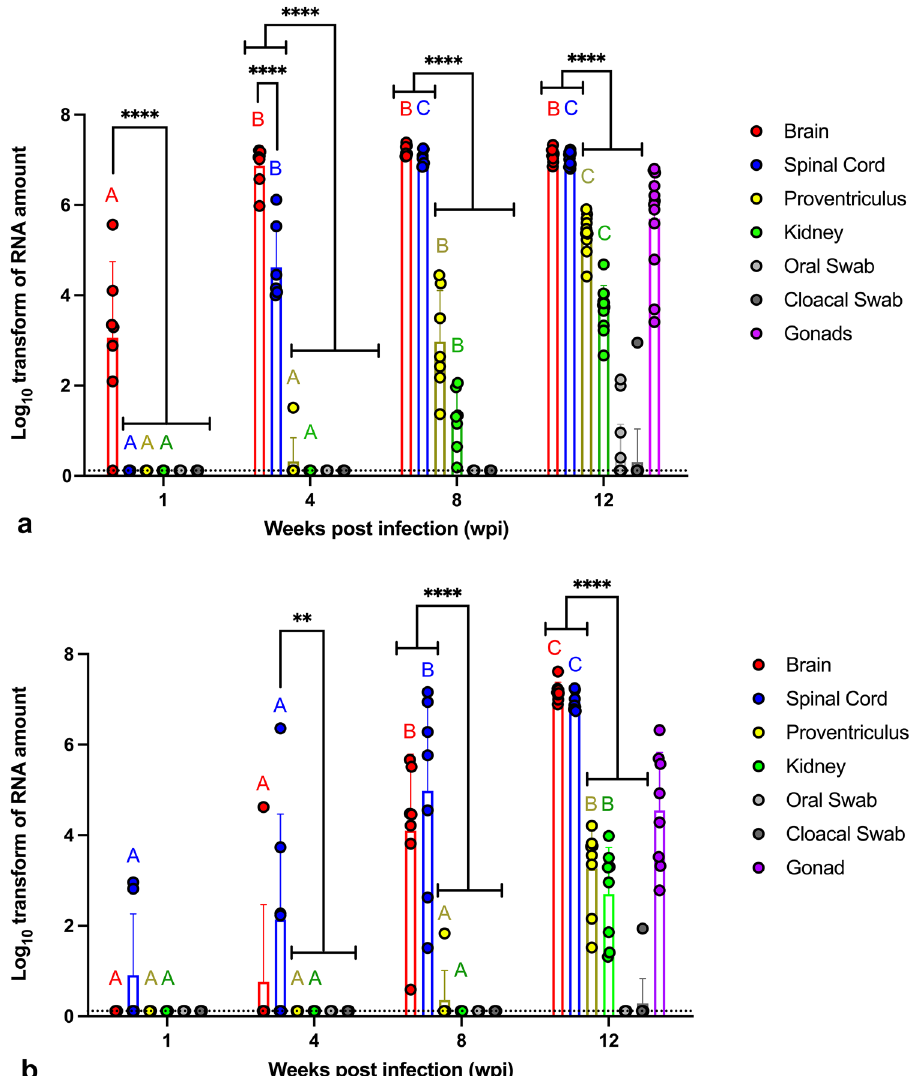
Figure 4. Scatter plot of virus RNA copies in multiple tissues and swabs from Muscovy ducks experimentally infected with ABBV-1 through the intracranial ( a ) or intramuscular ( b ) routes of infection, and assessed at 1, 4, 8, and 12 weeks post infection (wpi). Negative data points are represented at the calculated limit of detection (dotted line). Significant differences between terms within the same time point are identified with simple binary connectors. Flat lines at the end of a connector indicate differences with multiple underlying terms (significance level is reported for the highest p value among the comparisons). Differences for the same organ between time points are identified by different letters and color-coded (cerebrum, red; spinal cord, blue; proventriculus, yellow; kidney, green). Single datapoints represent the log 10 -transform of the virus RNA copies/150 µg of total RNA (tissues), or 84 µl of swab liquid. Columns represent mean + standard deviation. Two-way ANOVA with Tukey’s test for multiple comparisons (* < 0.05, ** < 0.01, *** < 0.001, **** < 0.0001). The limit of detection was calculated by extrapolating the value of the virus RNA copies corresponding to a Ct value of 35, based on the standard curve. Data points for gonads, as available only at 12 wpi, were not included in the statistical